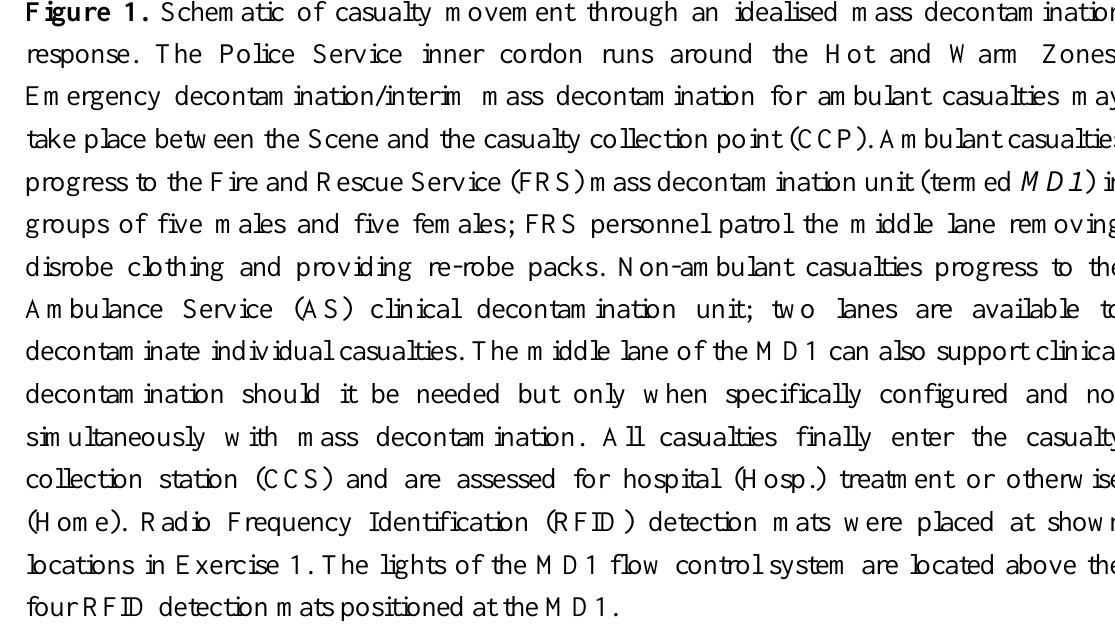
Figure 1. Schematic of casualty movement through an idealised mass decontamination response. The Police Service inner cordon runs around the Hot and Warm